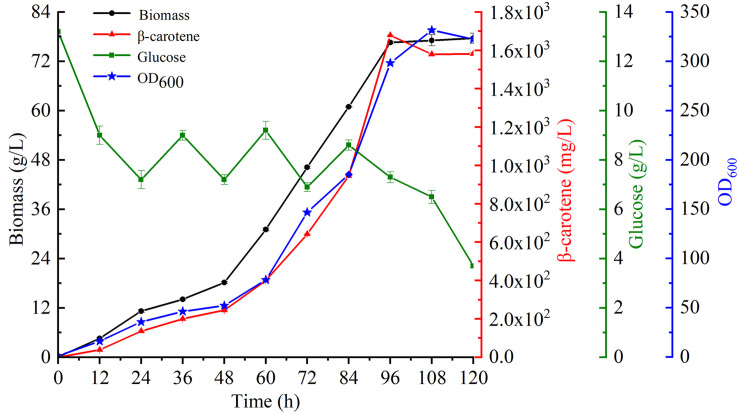
Biomass, β-carotene content, glucose consumption, and OD600 of YL-C6 in fermentation.